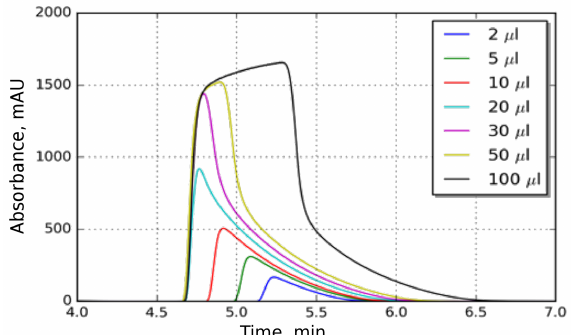
Figure 5. Peak shapes for the different injection volumes at 30 ◦